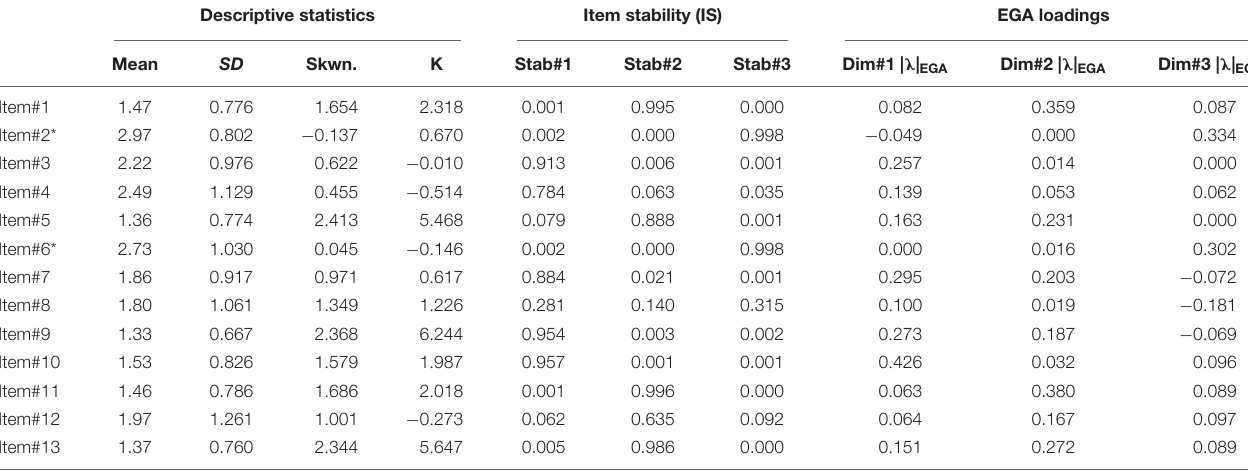
TABLE 1 | Study 1. Descriptive statistics of items and Exploratory Graph Analysis (EGA) results. Descriptive statistics